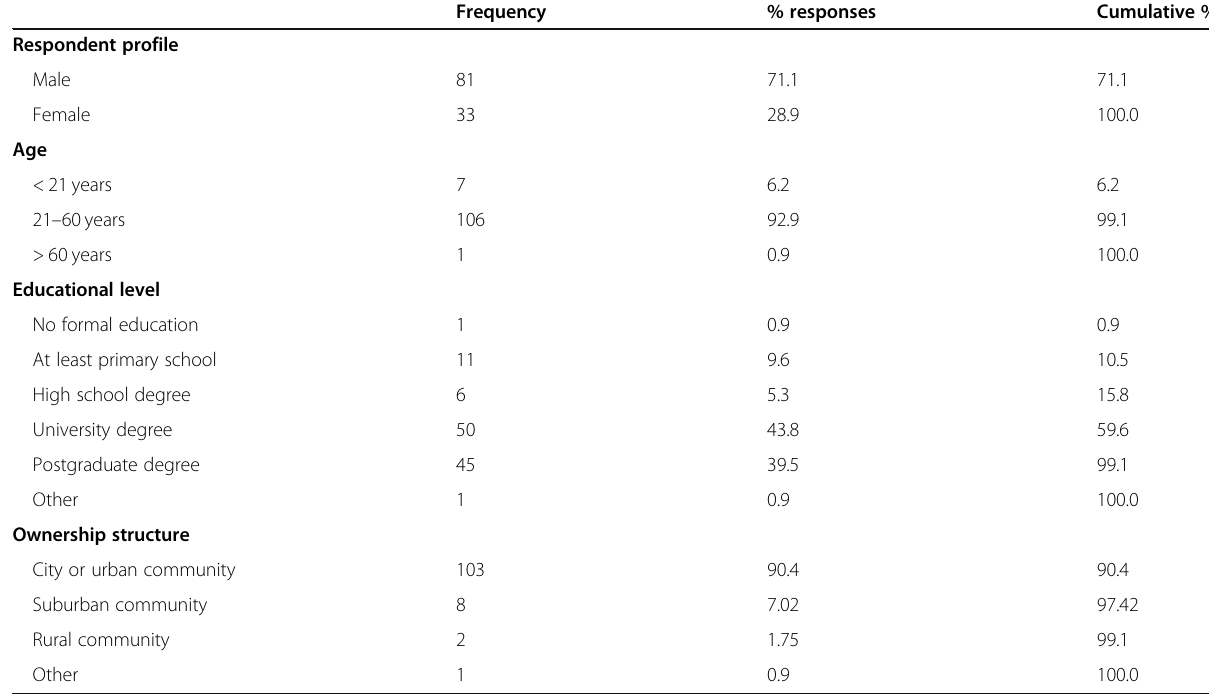
Table 1 Profile of respondents